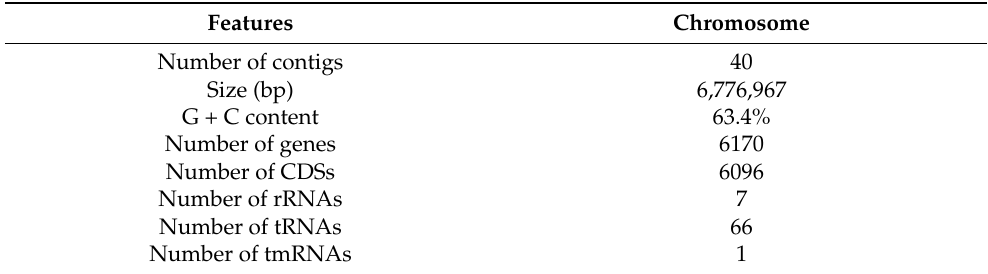
Table 1. Genome statistics for P. protegens FJKB0103.